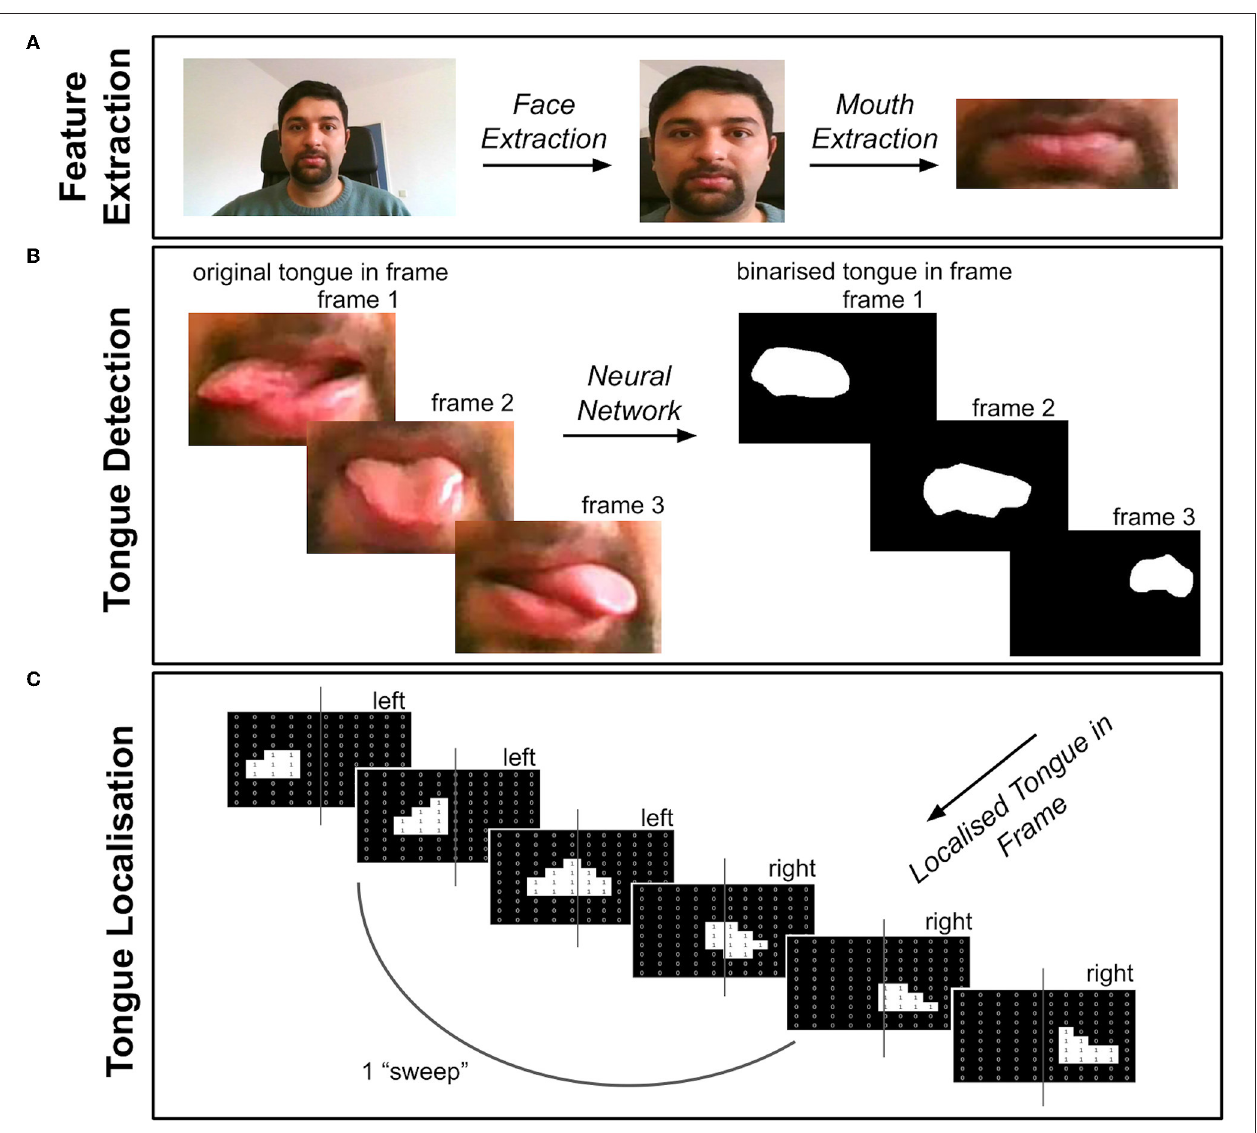
FIGURE 1 | Overview of Tongue Tracker (TT). The videos were first pre-processed via steps detailed in the text (see pre-processing section). (A) The face and mouth were detected and extracted from each frame of the pre-processed videos. (B) The tongue was then detected by using a trained neural network, resulting in a binary image showing the location of the tongue in each video frame. (C) A record of the location of the tongue, either in the left or right portion of the frame, was recorded and saved for extracting kinematic features of the tongue. The code can be accessed here: https://github.com/BudhaTronix/Automated-Video-Analysis-Tool-for-